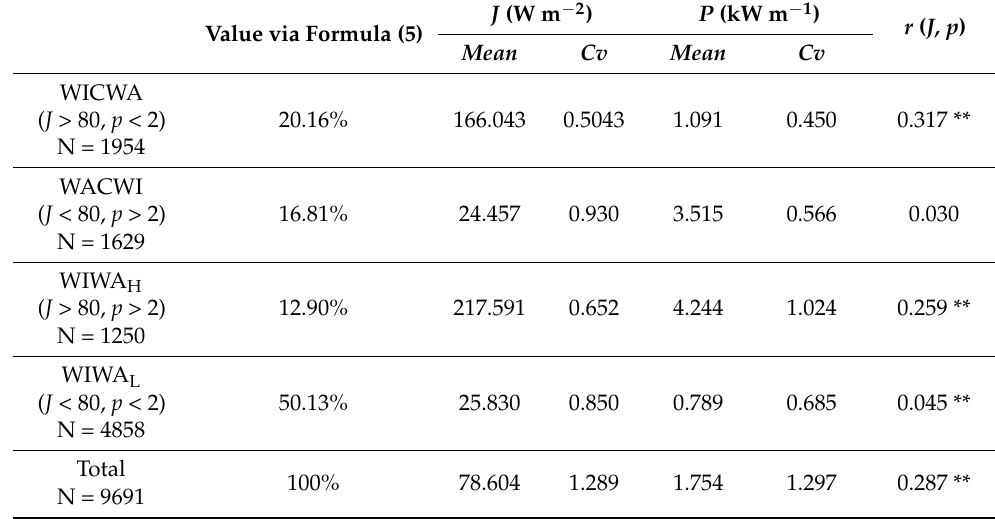
Table 4. Synergy aspects of the two resources.